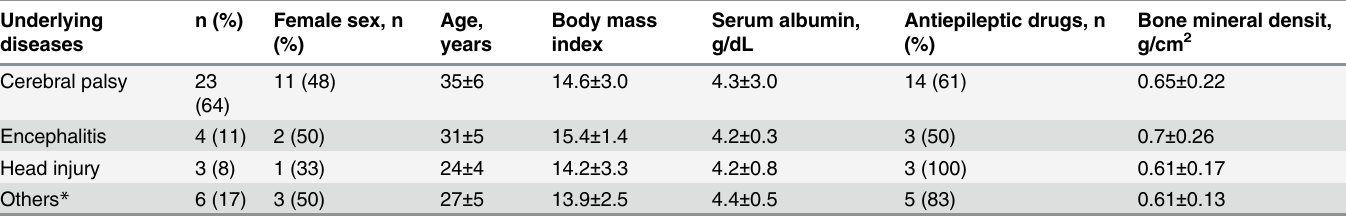
Table 2. Comparisons of clinical characteristics by underlying diseases. Underlying